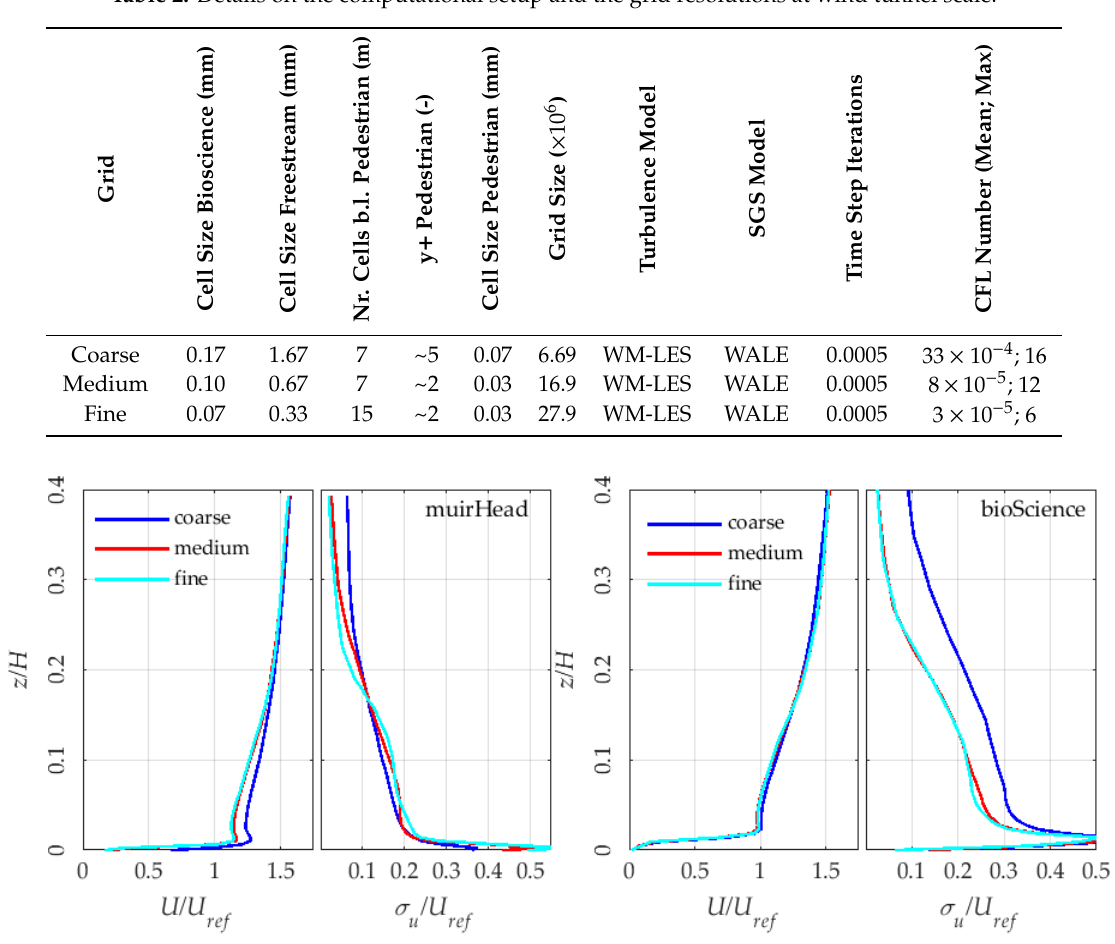
Table 2. Details on the computational setup and the grid resolutions at wind tunnel scale.